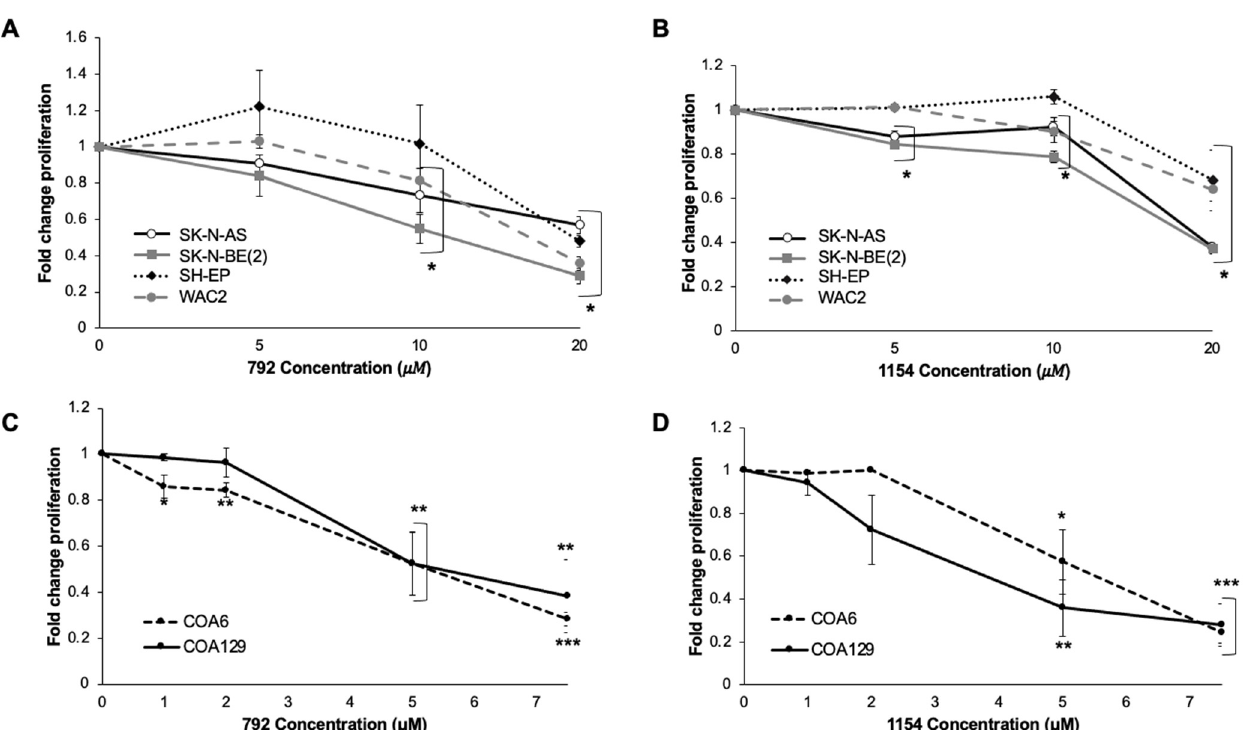
Figure 3. Treatment of neuroblastoma cells with 792 or 1154 resulted in decreased proliferation. Neuroblastoma cells (5 × 10 3 for SK-N-AS, SK-N-BE(2), SH-EP, WAC2, COA6; 1 × 10 4 for COA129) were plated in 96-well plates and treated with increasing doses of 792 or 1154 for 24 h. ( A , B ) Proliferation was significantly decreased in all long-term passage neuroblastoma cell lines following increasing concentrations of either 792 ( A ) or 1154 ( B ). ( C , D ) Increasing concentrations of either 792 ( C ) or 1154 ( D ) resulted in significantly decreased proliferation in the PDX cells. Data reported as mean fold change ± SEM, and experiments were repeated with at least three biologic replicates.